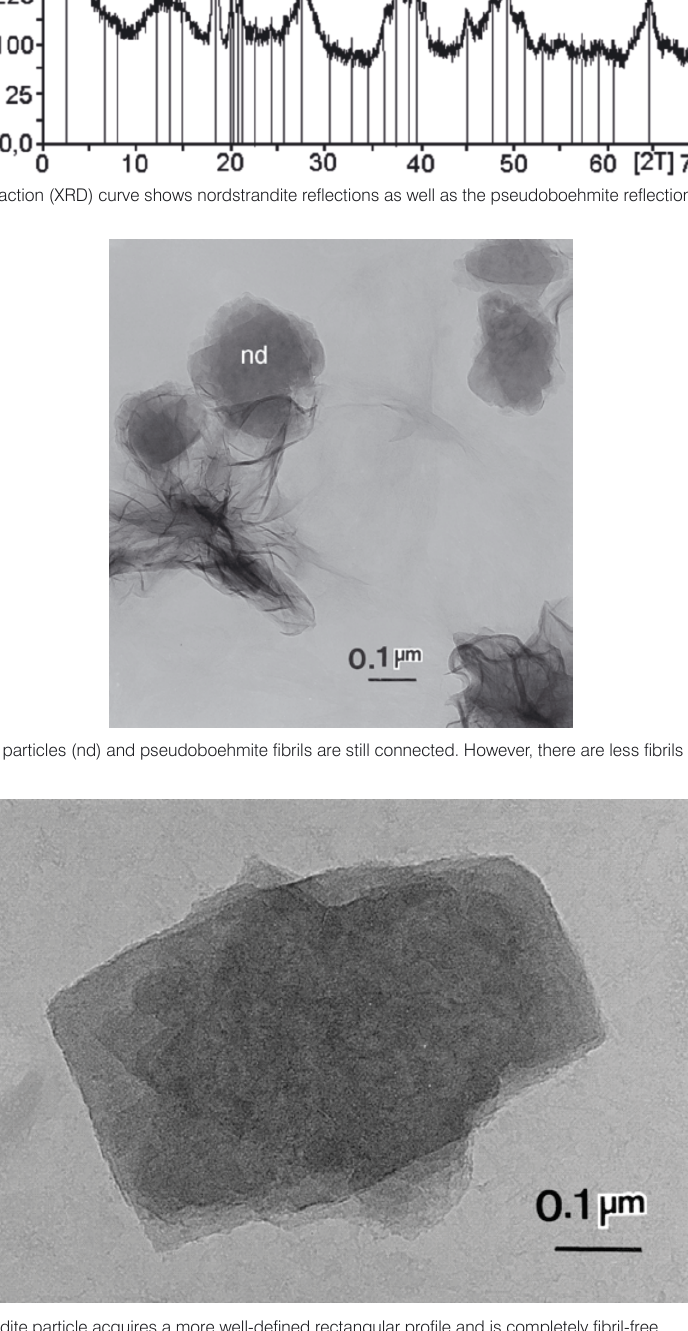
Figure 7. The nordstrandite particle acquires a more well-defined rectangular profile and is completely